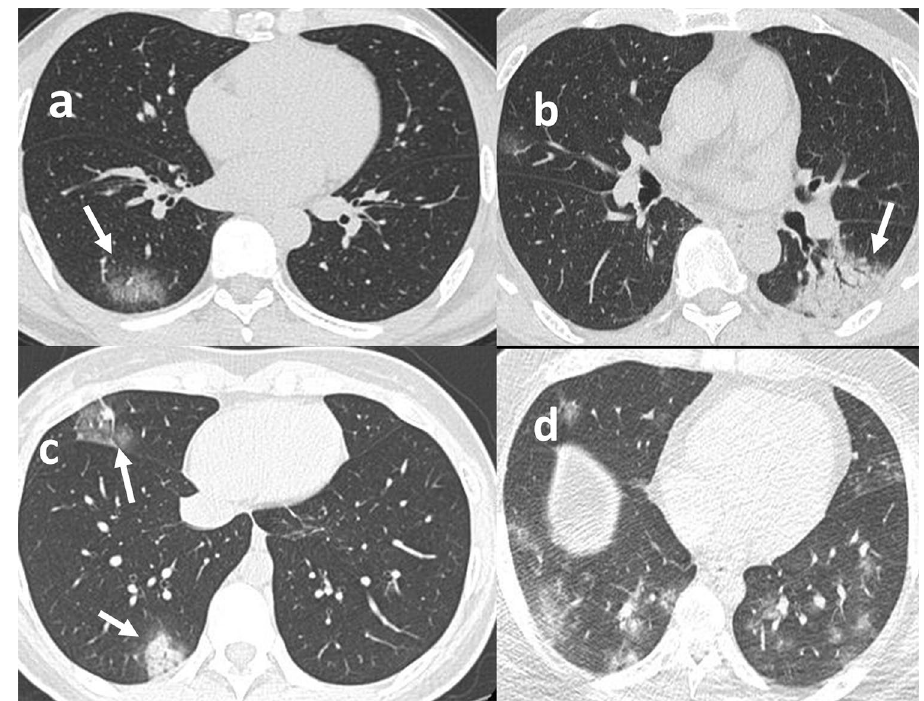
Figure 2. Chest CT findings of COVID-19 pneumonia. ( a ) GGO; ( b ) consolidation; ( c ) multifocal lesions; ( d ) bilateral